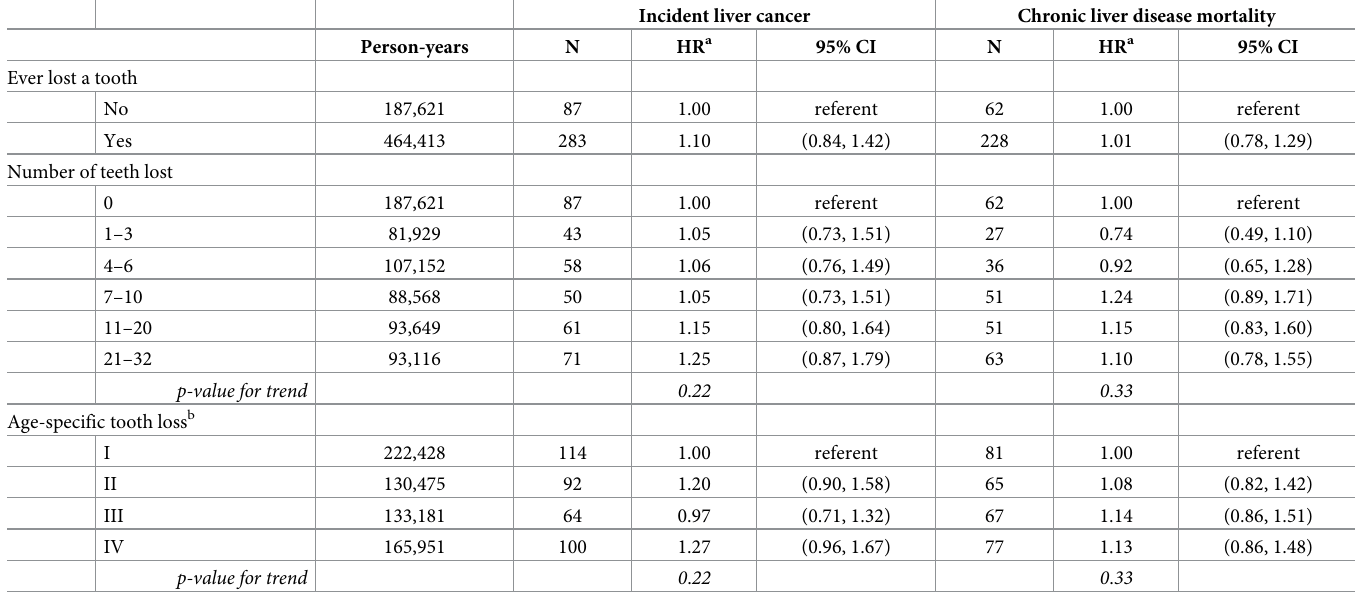
Table 2. Association of tooth loss to incident liver cancer and chronic liver disease (CLD) mortality in the Nutrition Intervention Trials Cohort, Linxian, China,